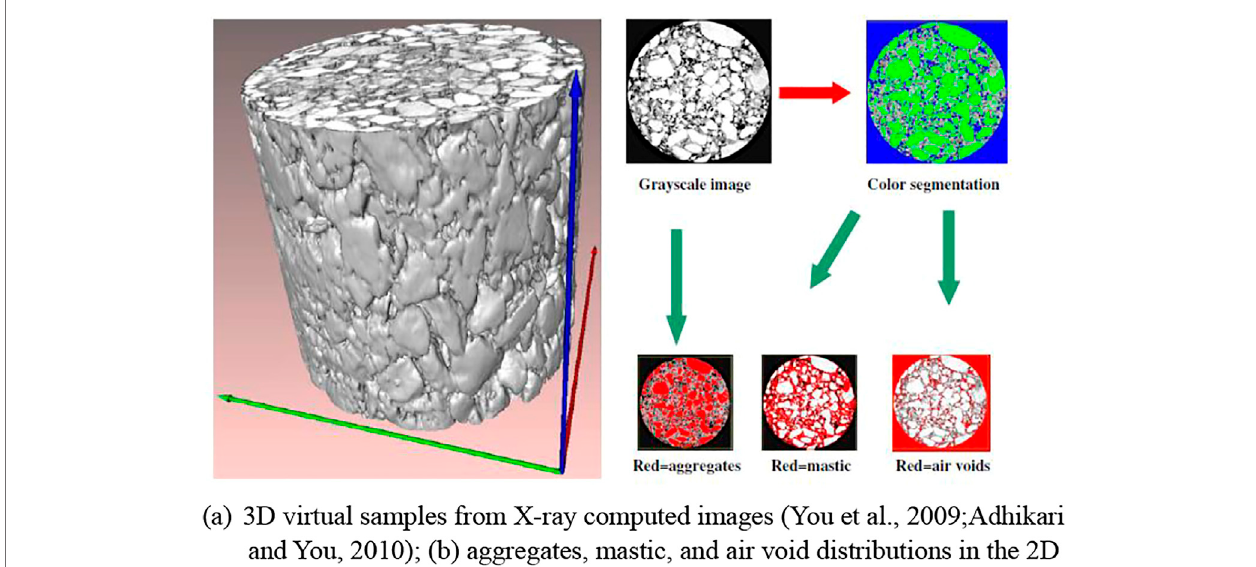
Frontiers in Materials |